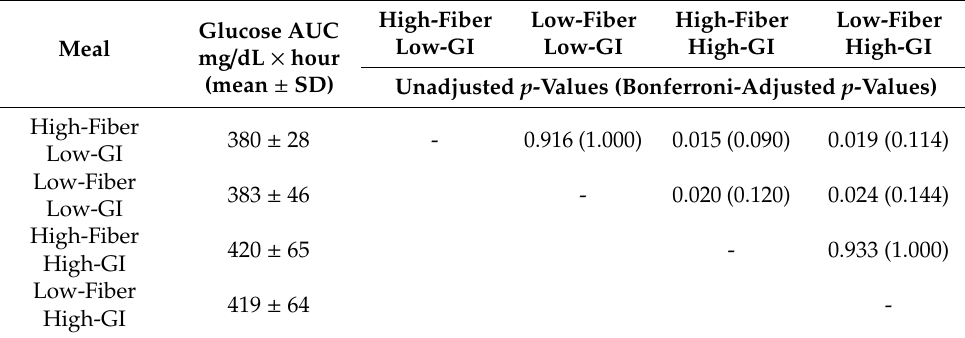
Figure 3. Glycemic response as area under curve (AUC) over 4 h in response to four meals di ff ering in glycemic index (GI) and fiber content. Boxes for each meal represent the interquartile range. Minimum and maximum values are indicated at the tips of each vertical line. The median for each meal is depicted by the horizontal line within each box. See Table 3 for statistical comparisons between meals. Table 3. Glucose area under curve: Comparisons between